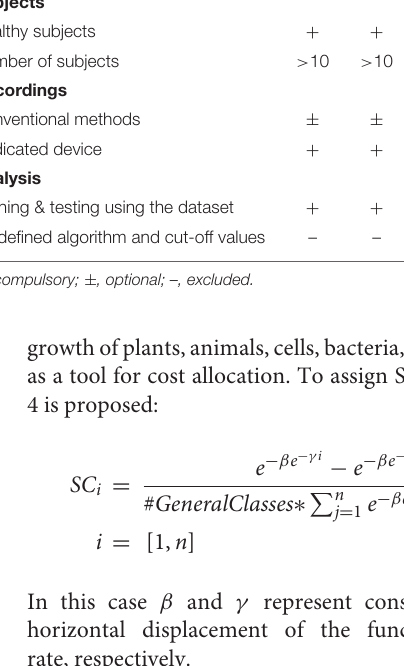
FIGURE 6 | Framework validation